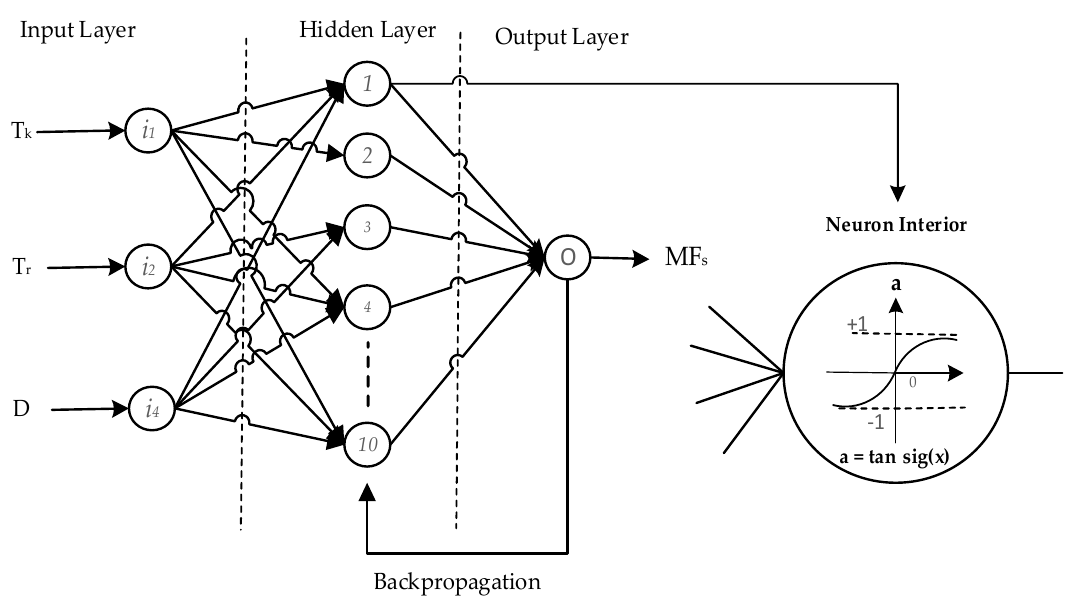
Figure 4. Structure diagram of the artificial neural network (ANN) in our proposed learning-to-control model.